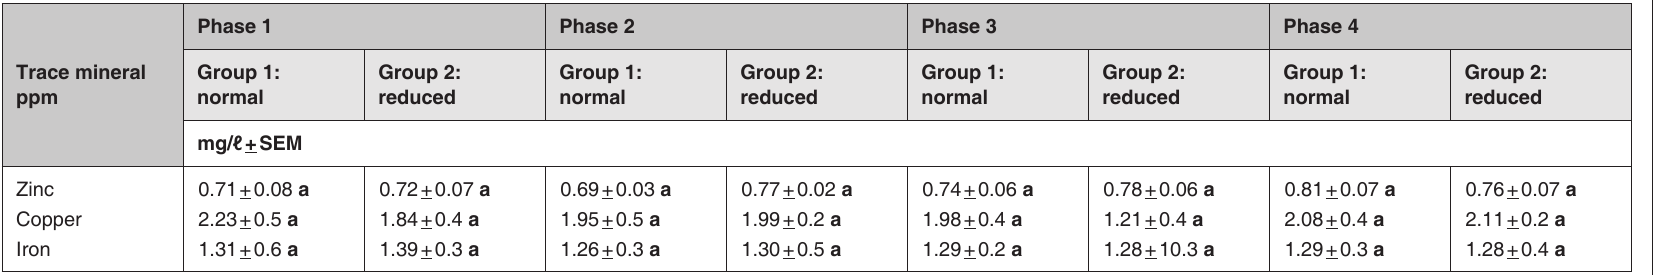
m a t e TABLE 4 Analysed trace mineral composition of the plasma of pigs. Group 1 received trace mineral levels as suggested by the NRC, USA (1998), while Group 2 received reduced levels